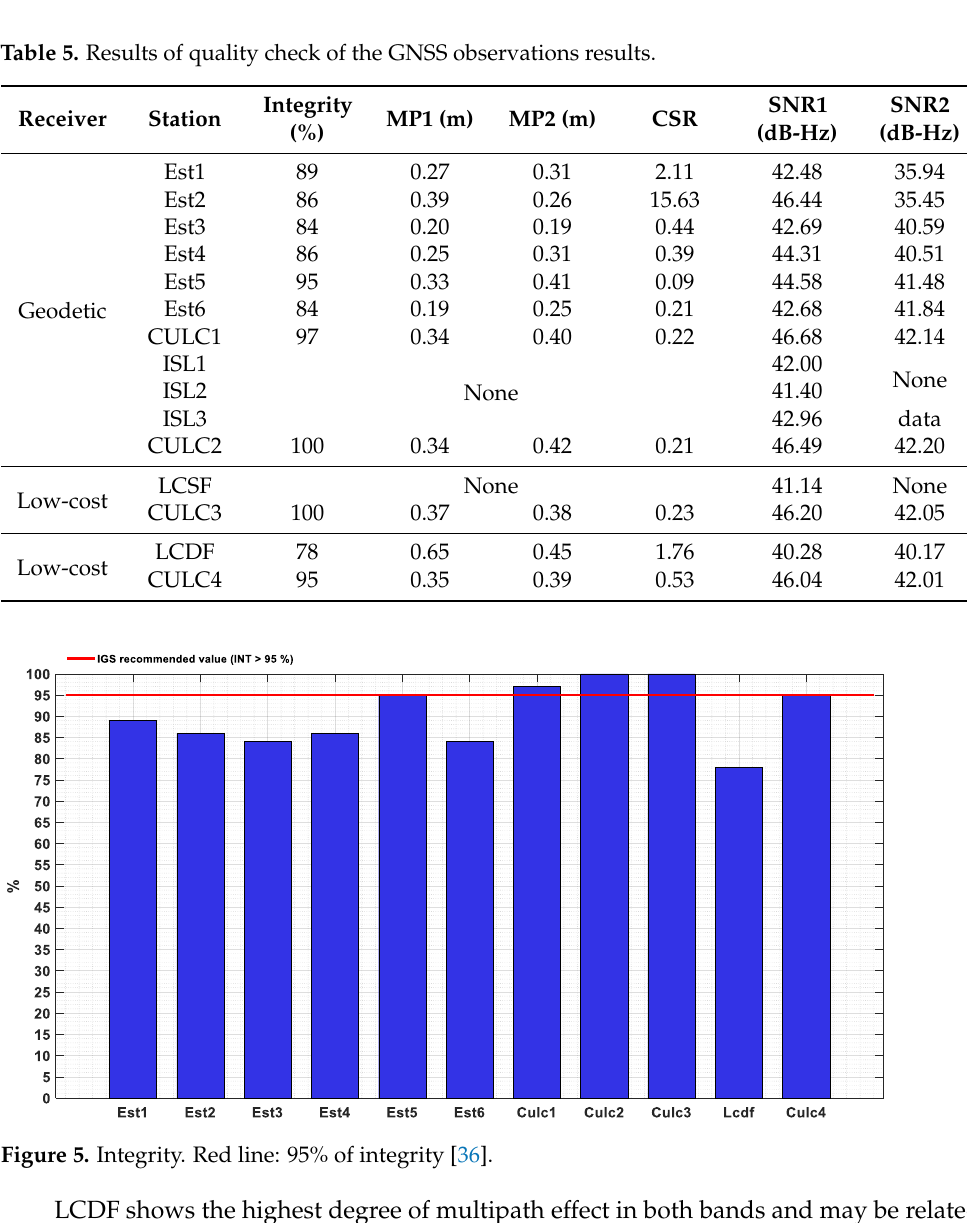
Figure 6. Multipath effect (MP1 and MP2). Red line: maximum value of 0.30 m for the multipath effect [36]. With the signal-to-noise ratio and the multipath effect, a weak SNR would be ex- pected in most stations, since both variables have an inversely proportional behavior [55],